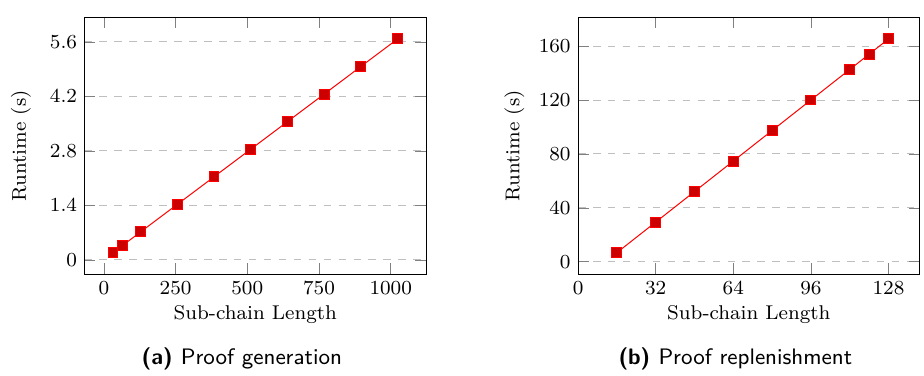
Figure 8: Runtimes of Proof of Aliveness (PoA).